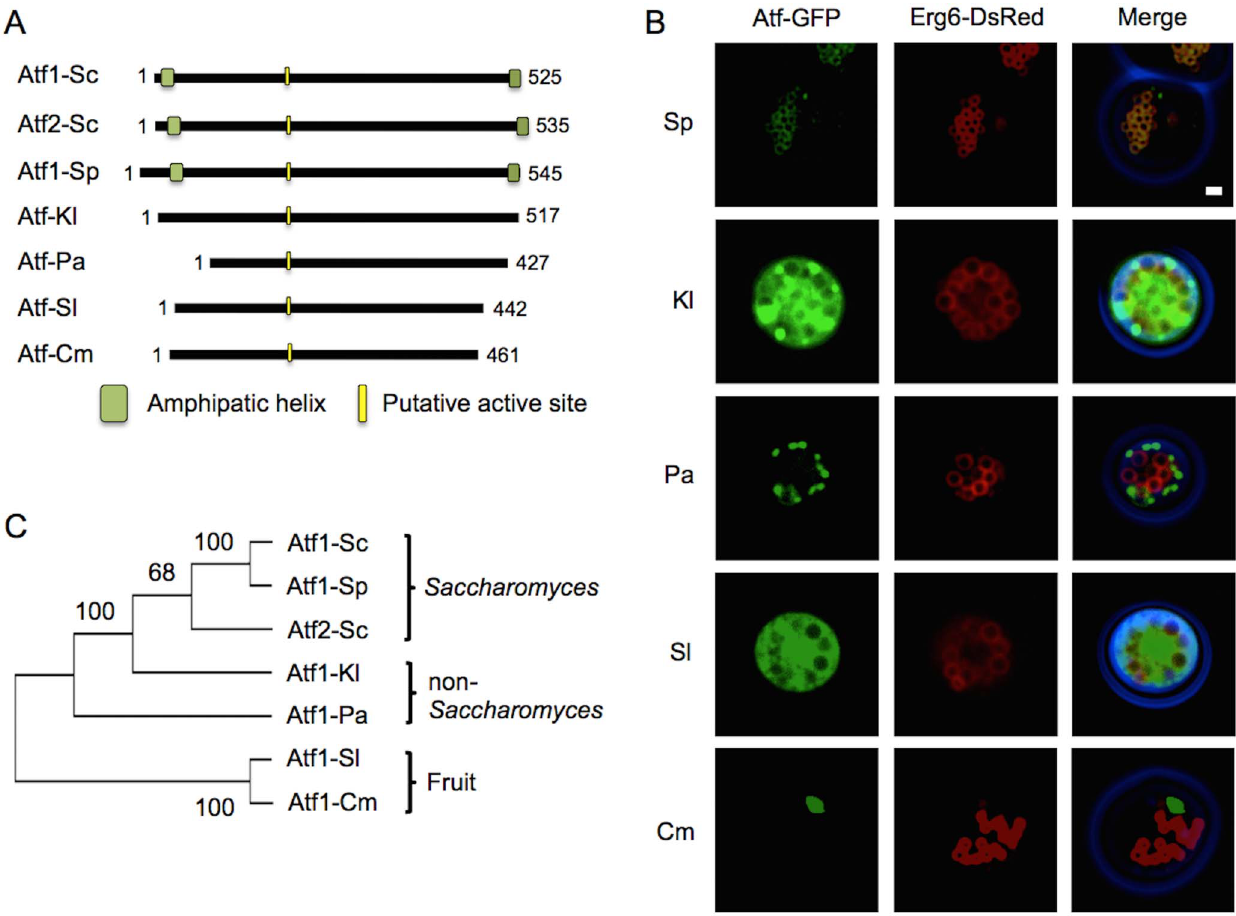
Figure 7. N- and C-terminal amphipathic helices are necessary for LD localization of Atfs. (A) Schematic representation of the amino acid sequences of Atf orthologs from S. cerevisiae (Sc) S. pastorianus (Sp), the non-Saccharomyces yeast Kluyveromyces lactis (Kl) and Pichia anomala (Pa), and the fruit Solanum lycopersicum (Sl) and Cucumis melo (Cm). Predicted amphipathic helices and the putative active site (HXXXD) are shown in green and yellow, respectively. The length of the primary sequence is given at the end of the schematic for each enzyme. (B) Fluorescent images of stationary phase cells co-expressing Atf-GFP and the LD marker Erg6-DsRed. Atf1 from the Saccharomyces yeast S . pastorianus localizes to LDs, while orthologs that do not have predicted amphipathic helices at the N- and C-termini, including K. lactis , P. anomala , S. lycopersicum , and C. melo do not localize to LDs. Scale bar, 1 m m. (C) Phylogenetic tree of the studied Atfs. Amino acid sequences were obtained from National Center for Biotechnology Information and aligned by Clustal W [57]. Phylogenetic analysis was implemented in Mega 5.2.2, and trees were constructed by neighbor-joining algorithm [58]. Bootstrap values are displayed at the nodes.